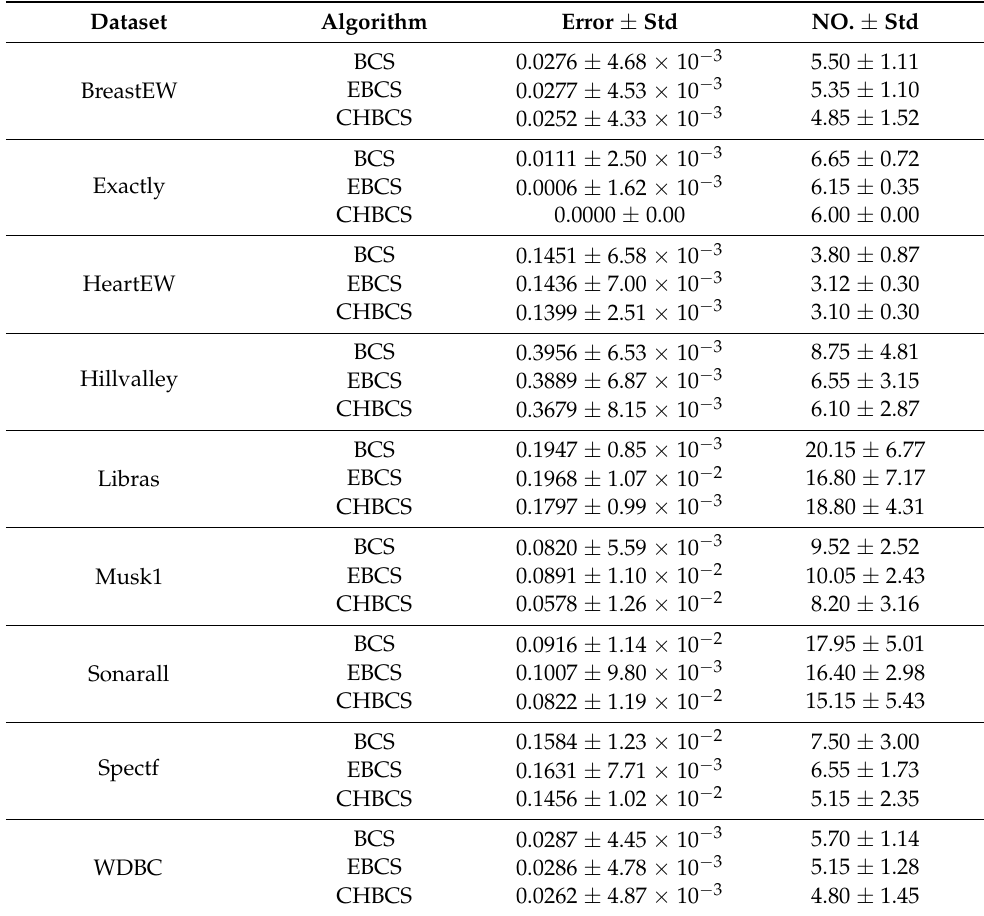
Table 3. Classification results of three